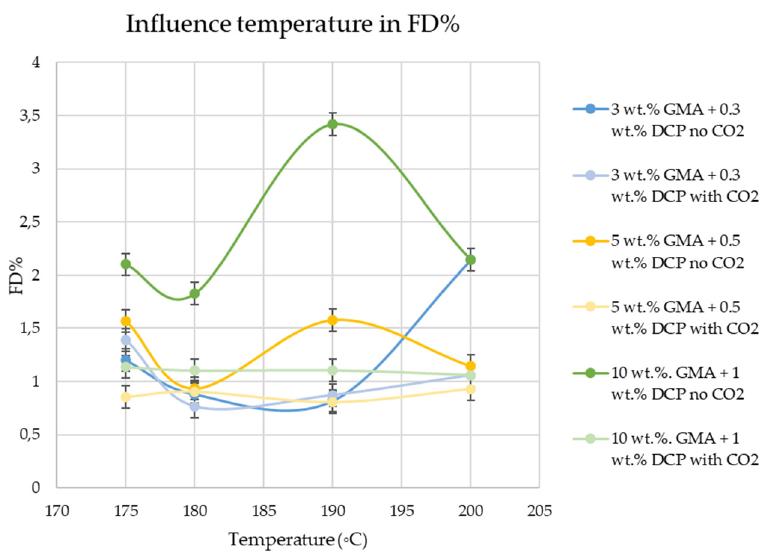
Figure 6. Temperature influence of FD on RPE samples.